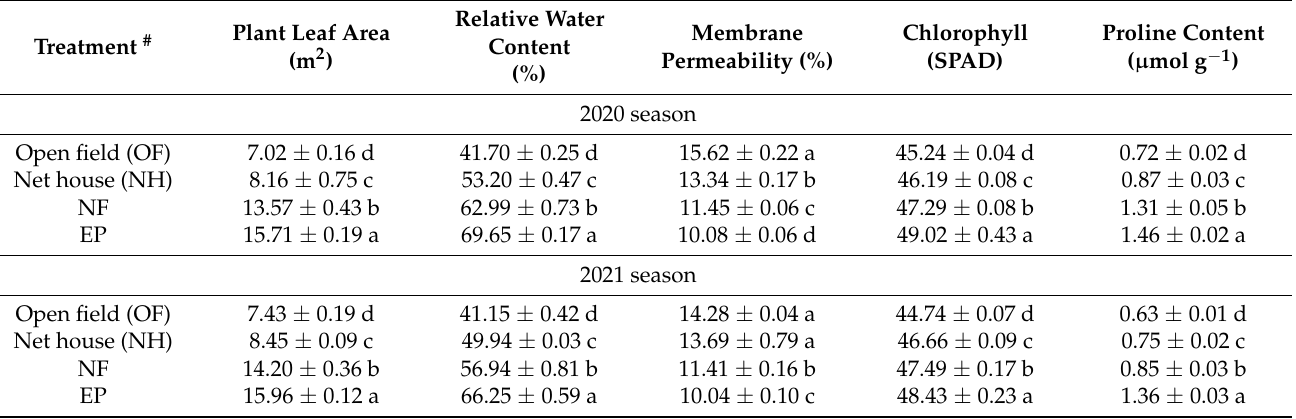
Table 1. Changes in some physiological and biochemical traits in relation to reduced heat stress on grown tomato under modified walk-in tunnels compared to open-field